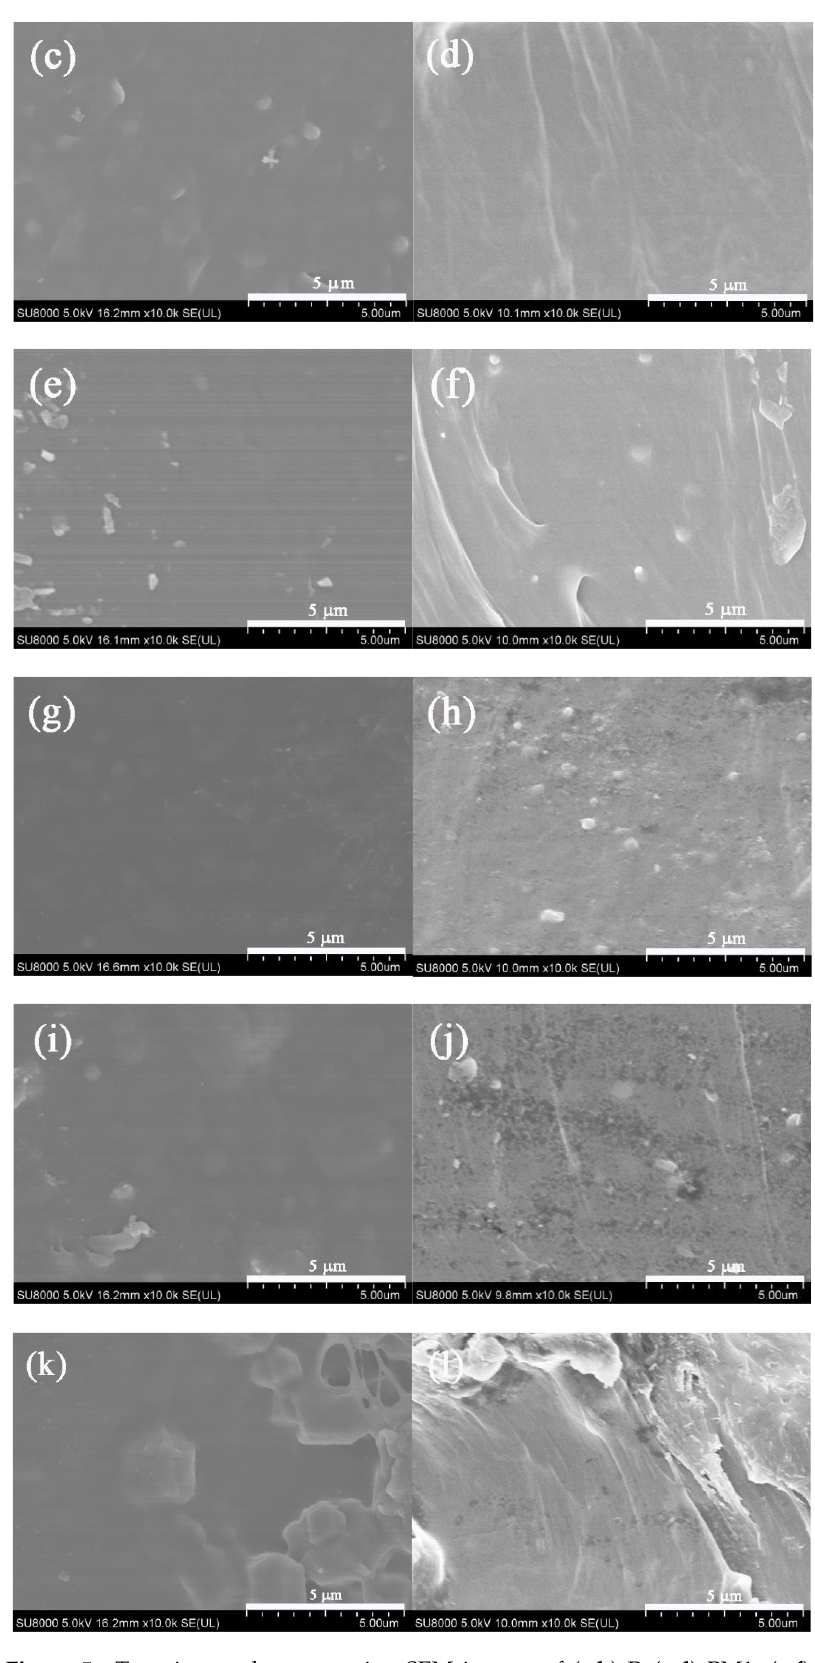
Figure 5. Top-view and cross-section SEM images of ( a , b ) P, ( c , d ) PM1, ( e , f ) PM3, ( g , h ) PM5, ( i , j ) PM7, and ( k , l )